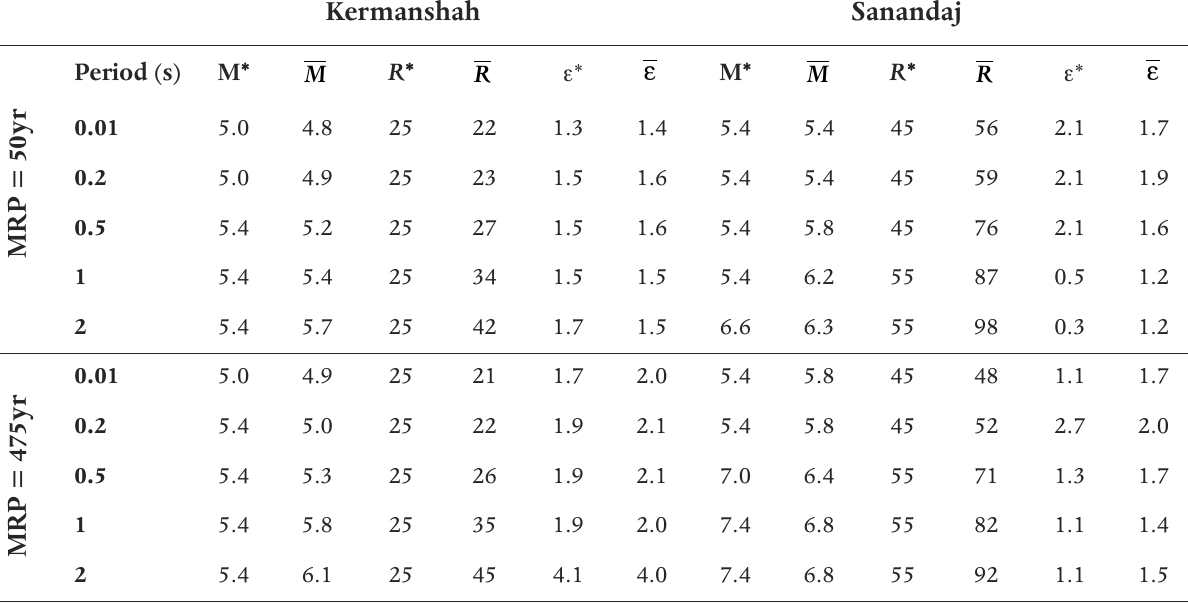
Table 2. Modal and mean values of magnitude, distance and epsilon for spectral periods in Kermanshah and Sanandaj, Sa (0.01s) repre- sents the